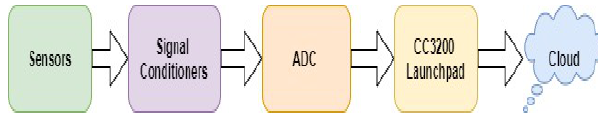
Figure 6 . Process flow diagram of the IVMS